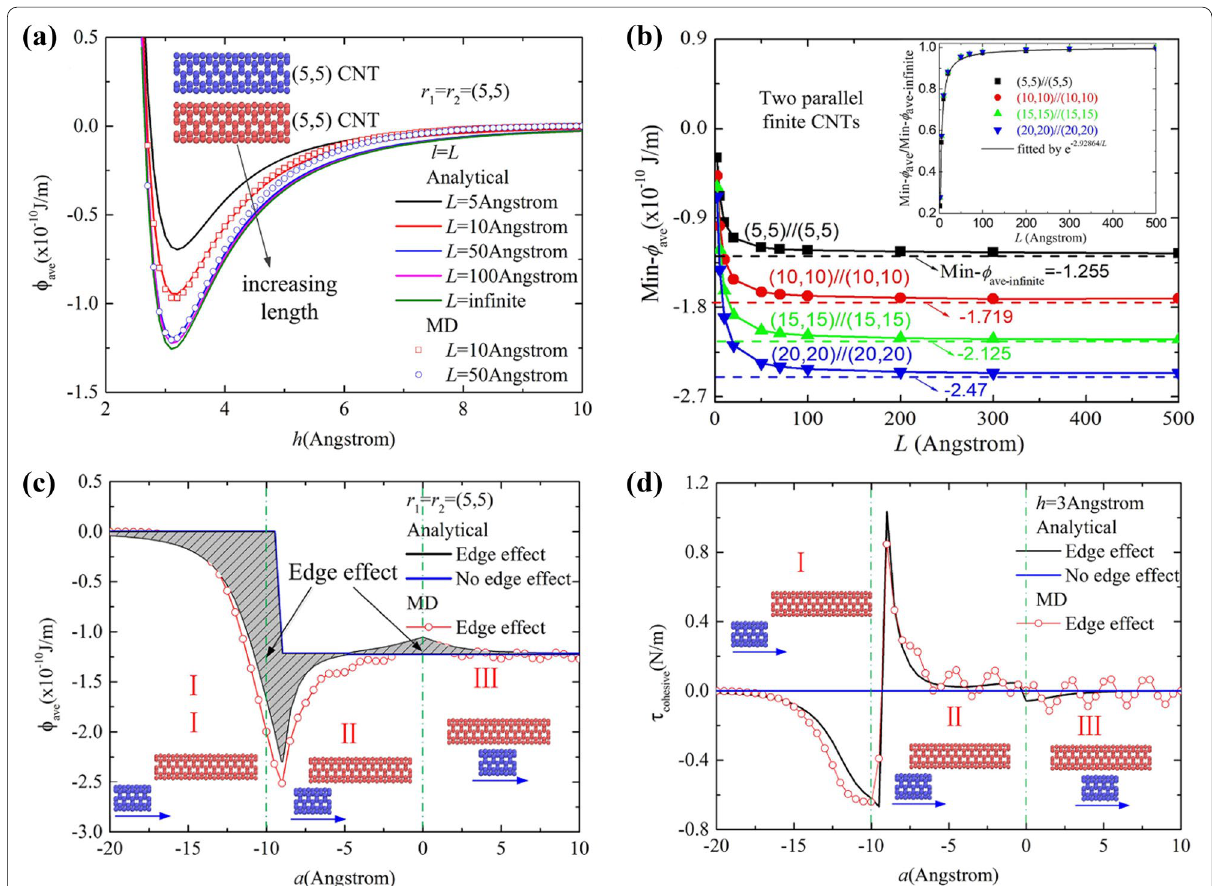
Figure 8 Size-effect and edge-effect cohesive energy between two parallel finite CNTs [70]: ( a ) The distribution of average cohesive energy between two parallel finite CNTs with different vertical distance h , ( b ) The distribution of the minimum average cohesive energy Min- φ ave between two (5,5) CNTs with different length L (inset represents the normalized Min- φ ave ). The distribution of ( c ) the average cohesive energy and ( d ) the shear stress with different lateral distance